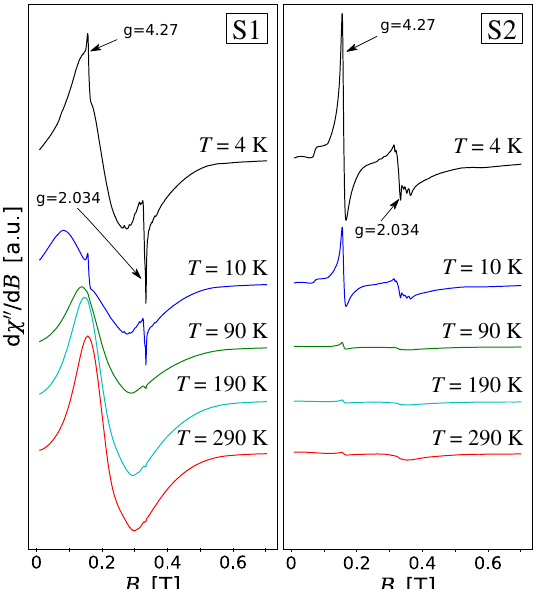
Figure 4. Absorption lines derivatives, d χ (cid:48)(cid:48) /d B , of the samples S1 and S2 at different temperatures. The plots have been shifted relative to each other for greater